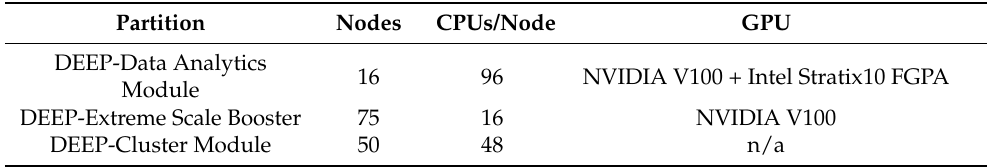
Table 1. Partitions on the DEEP prototype. Partition Nodes CPUs/Node GPU DEEP-Data Analytics 16 96 NVIDIA V100 + Intel Stratix10 FGPA Module DEEP-Extreme Scale Booster 75 16 NVIDIA V100 DEEP-Cluster Module 50 48